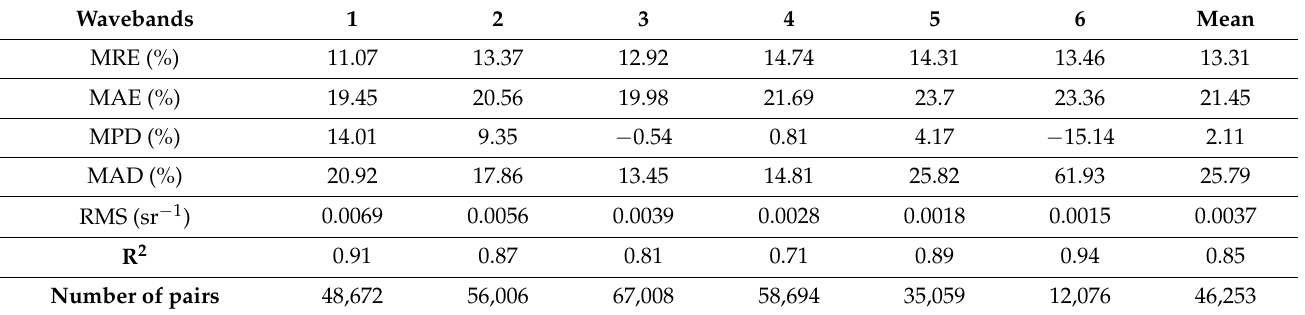
Table 5. The evaluation of the R rs of COCTS/HY ‐ 1D on 2 October 2020, using those of Aqua as the truth values.